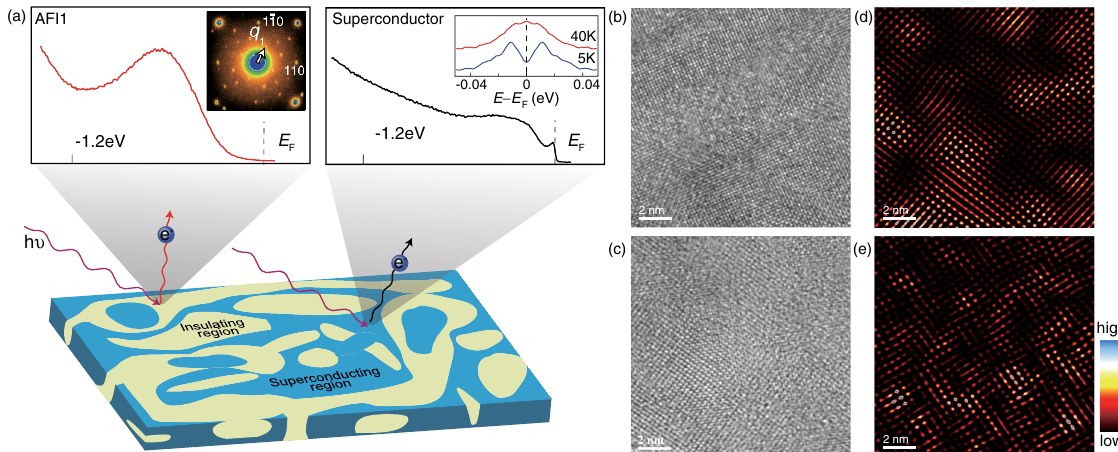
FIG. 5. (a) Cartoon for mesoscopic phase separation in superconducting K x Fe 2 (cid:1) y Se 2 . Different regions exhibit different photoemission-spectroscopic signatures. Inset in the left panel of (a): The diffraction pattern of the with TEM in both the superconductors and semiconductors, indicating a mixing of either the superconducting or the semiconducting phase with the AFI1 phase. The arrow in the diffraction pattern indicates the superlattice-modulation wave vector q 1 ¼ ð 1 = 5 ; 3 = 5 ; 0 Þ . The TEM data was collected at room temperature. Inset in the right panel of (a): The symmetrized EDCs of the superconductor across T c , illustrating a superconducting gap. (b) and (c) The typical raw HRTEM image of the semiconducting sample and superconducting sample, respectively. (d) and (e) The effective-dark-field images constructed from the images in (b) and (c) by using the ( (cid:2) 1 = 5 , (cid:2) 3 = 5 , 0) superstructure spots as described in the text. In such dark-field images, only the image contrast, and the mesoscopic phase separation of vacancy-ordered (brighter) and vacancy-disordered (darker) regions is clearly